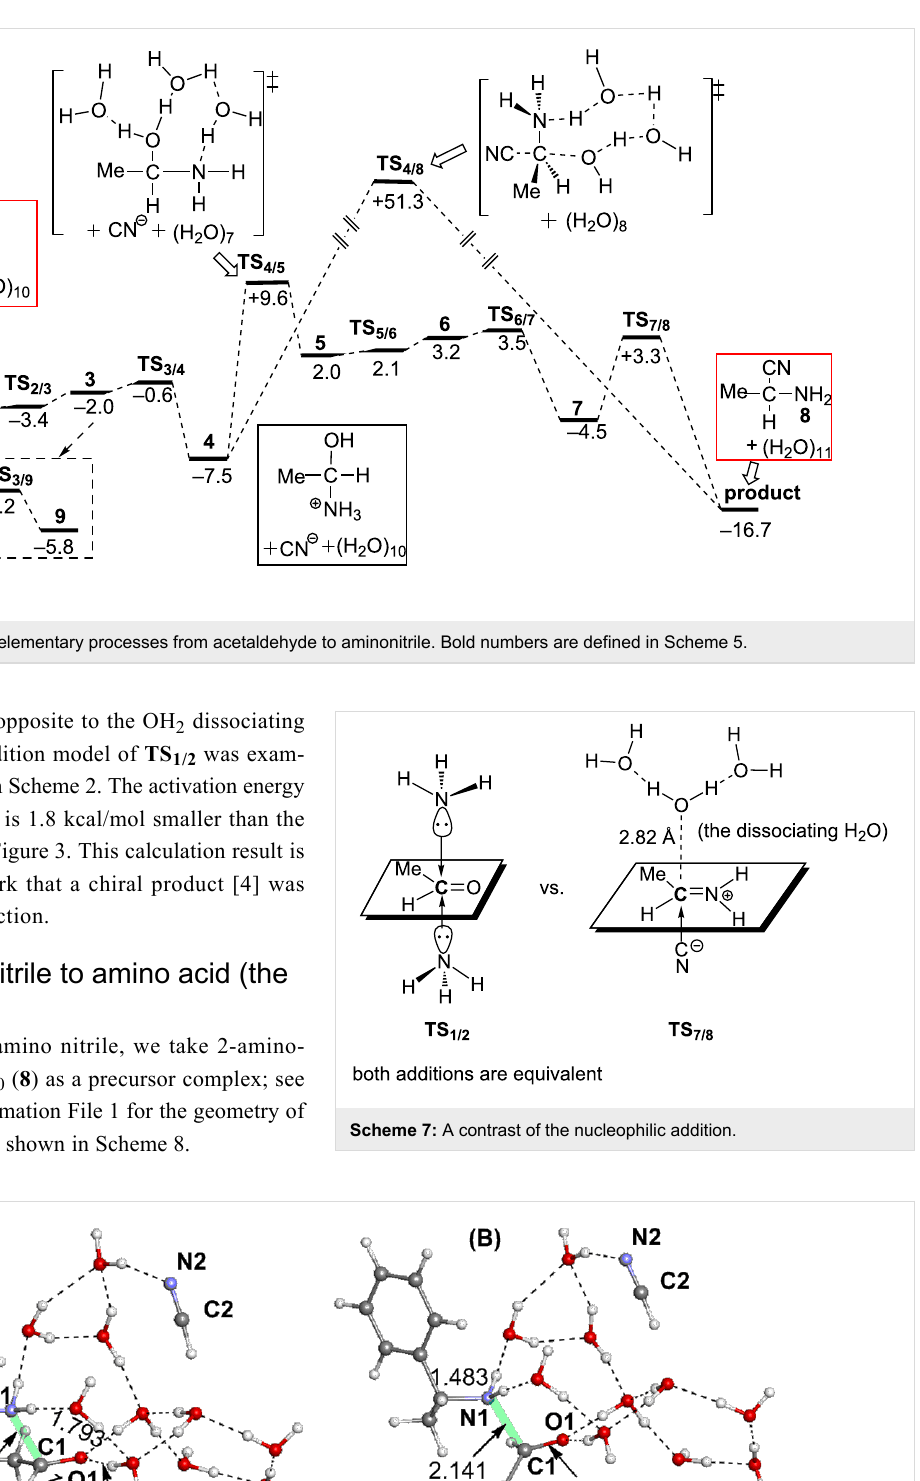
Figure 3: Two transition states (A and B) of the nucleophilic addition of (S)- α -phenylethylamine to acetaldehyde. (H 2 O) 10 is also included, and the molecular formula of the reaction system is C 11 H 36 N 2 O 11 .